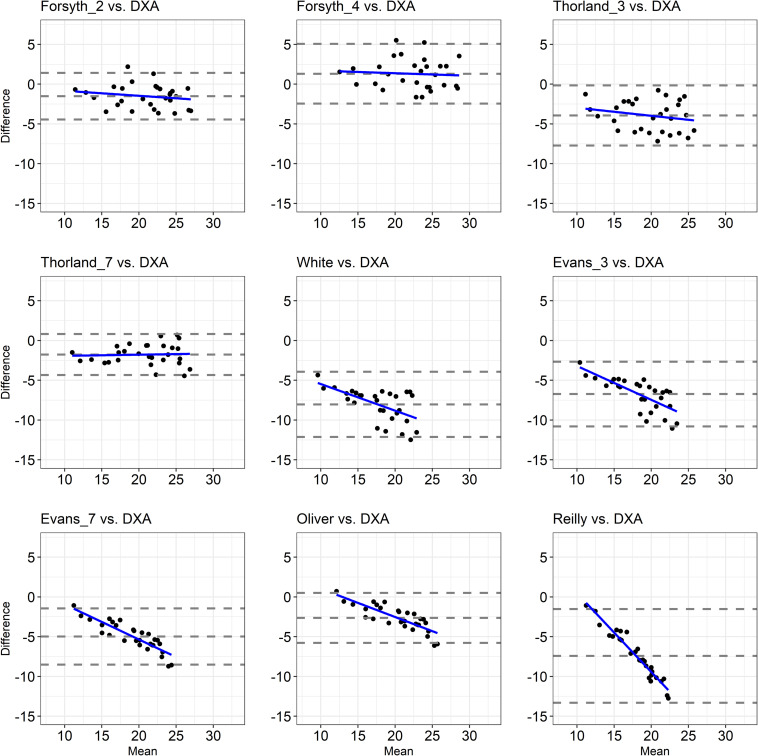
Bland-Altman Plots showing the agreement between the %FM assessed through anthropometric equations validated upon able-bodied athletic populations and the %FMDXA. The dashed lines indicate bias ± 2 standard deviations and the solid blue line indicates the regression line.